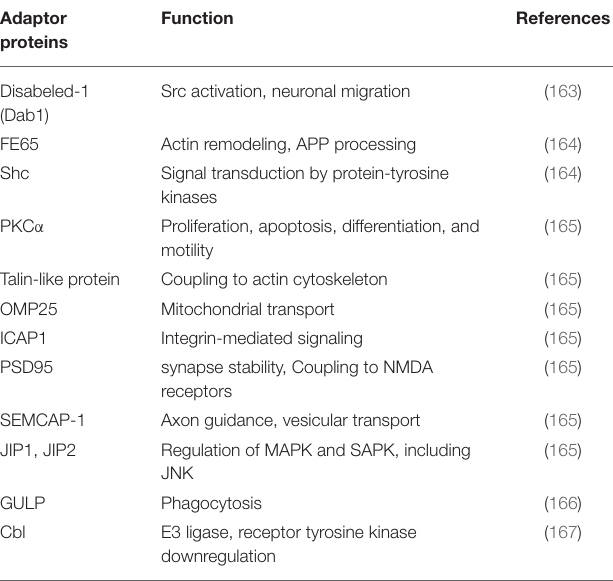
TABLE 2 | Adaptor proteins known to bind to the cytoplasmic domain of LRP1. Adaptor proteins